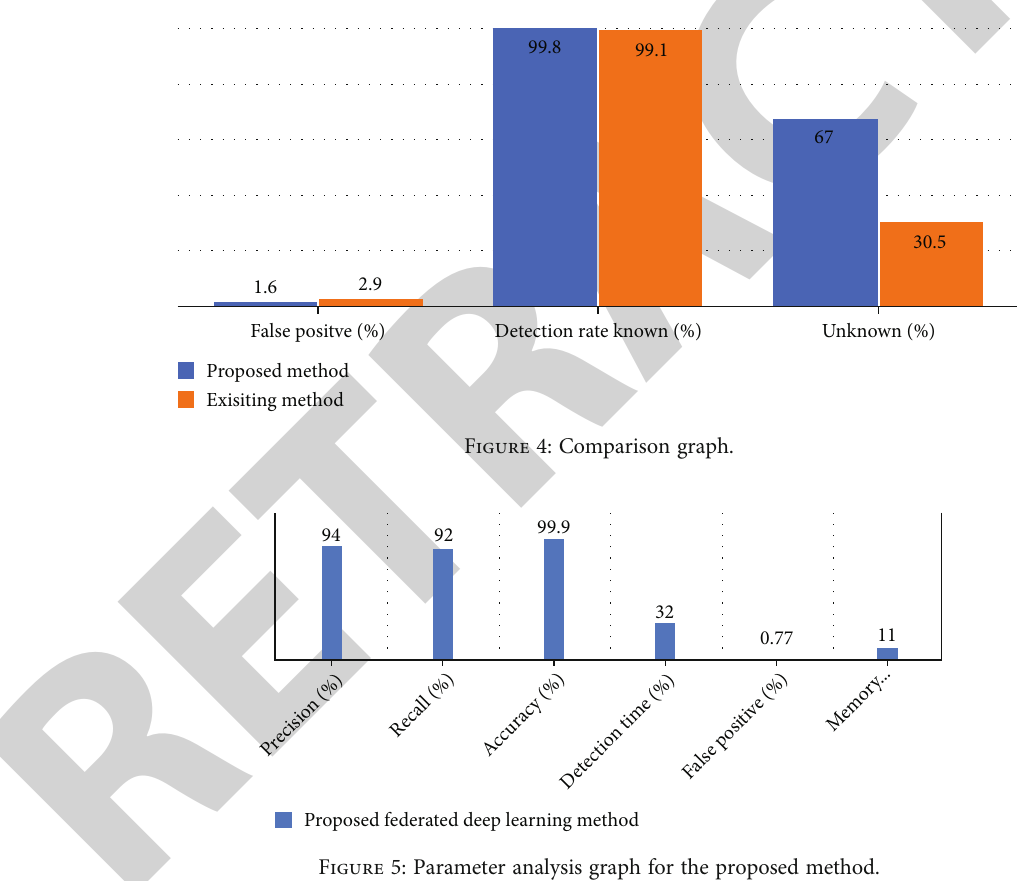
Figure 3: Comparison graph between the existing and proposed methods.